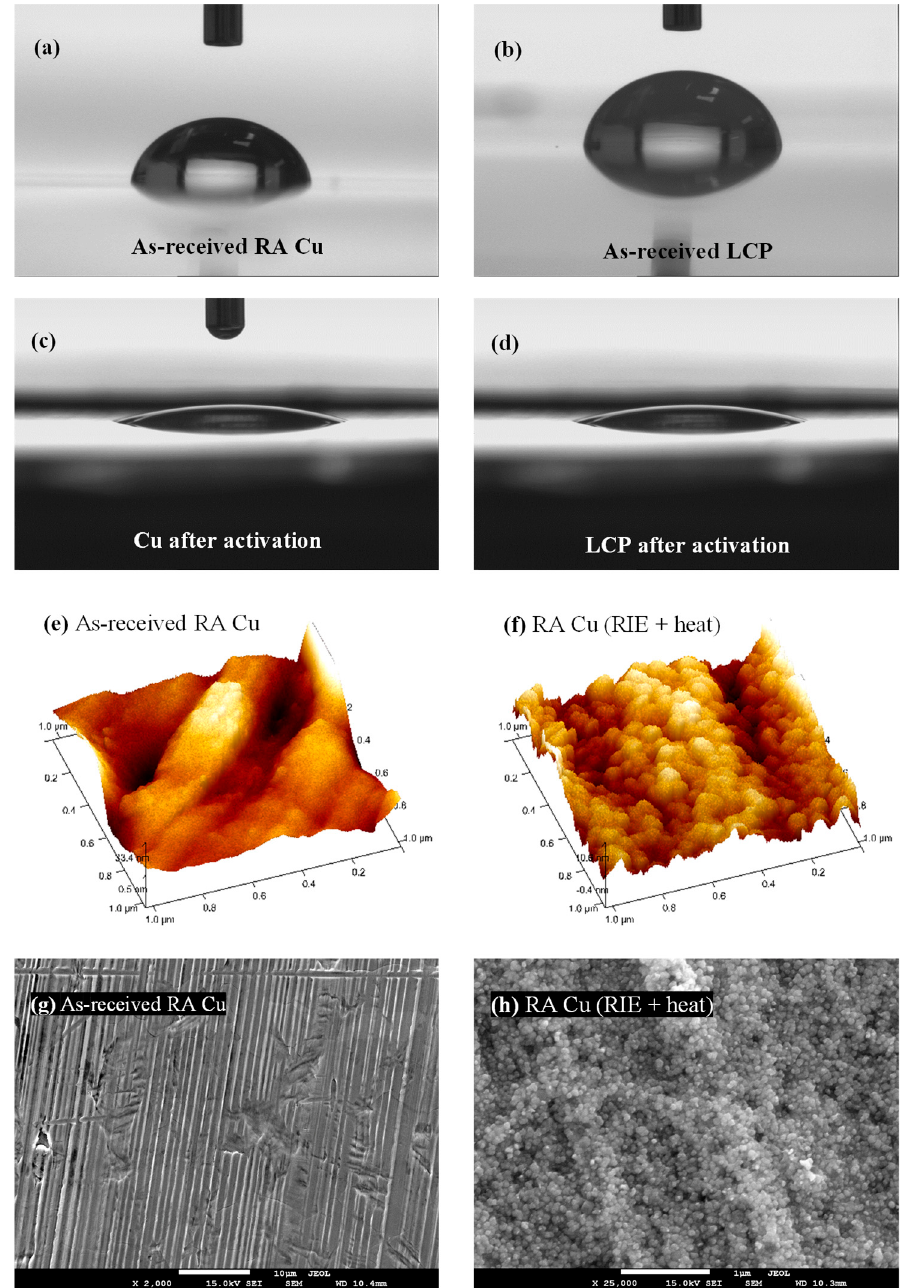
Figure 2. ( a – d ) Water contact angles (using 6 µL water drop, viewing angle = 4°) of: ( a ) as-received RA Cu (~79°), ( b ) as-received LCP (~83°), ( c ) activated RA Cu (~13°), and ( d ) activated LCP (~11°). The O 2 -RIE plasma treatment (Table 1) made Cu and LCP highly hydrophilic. ( e , f ) Surface morphology of 1 × 1 µ m 2 as-received RA Cu before and after plasma (followed by heat) treatment. ( g , h ) SEM image of RA Cu before and after plasma